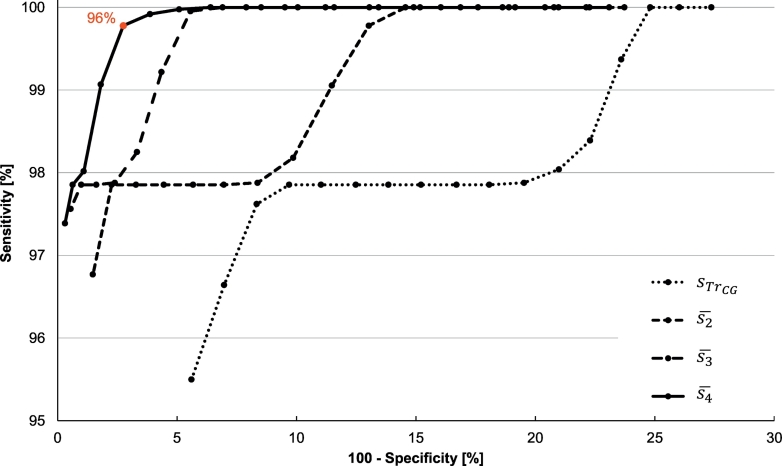
The ROC curves for the delineation based on sTrCG, s¯2 (the average similarity of parameters TrCG and Diffp), s¯3(the average similarity of parameters TrCG, Diffp, and Tr0), and s¯4 (the average similarity of all parameters) for the similarity threshold 90–98%, step 0.5%. The red value is the similarity threshold for which the best sensitivity and specificity results were obtained. (For interpretation of the references to color in this figure legend, the reader is referred to the web version of this article.)